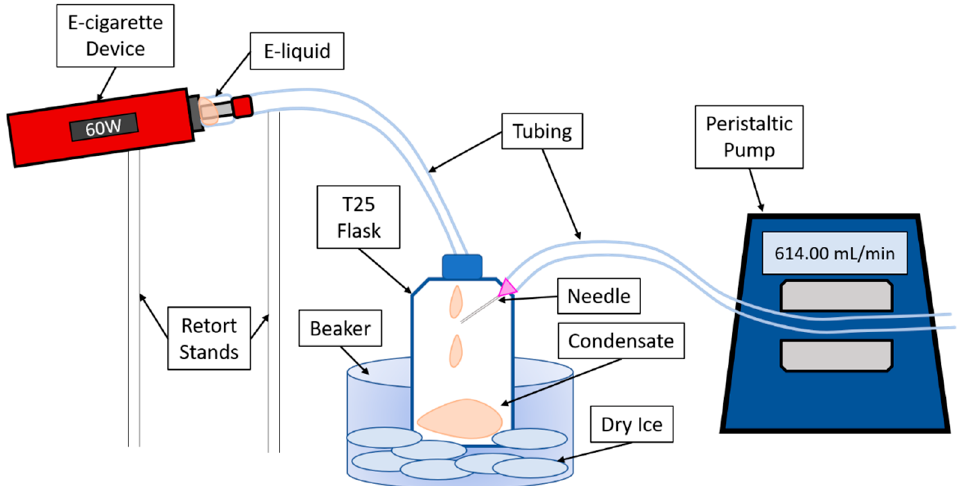
Figure 1. Diagram of electronic cigarette aerosol condensate generation.